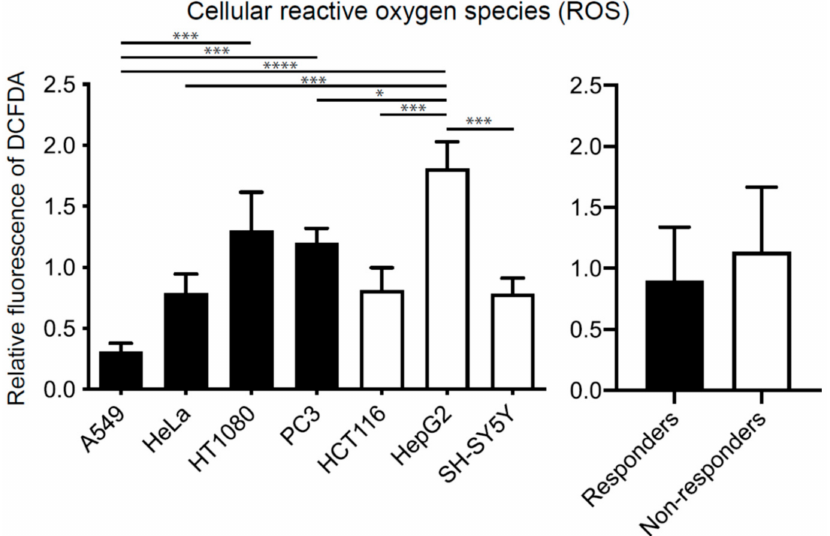
Figure 2. Basal concentrations of cellular reactive oxygen species (ROS) in seven cell lines. The fluorescence of DCFDA was normalized for the global average of the seven cell lines. Mean and SD are indicated ( n = 3 culture dishes). * p < 0.05, *** p < 0.001 and **** p < 0.0001 by one-way ANOVA followed by Tukey’s multiple comparison test. No statistical difference ( p = 0.28) by Student’s t -test between the responders and